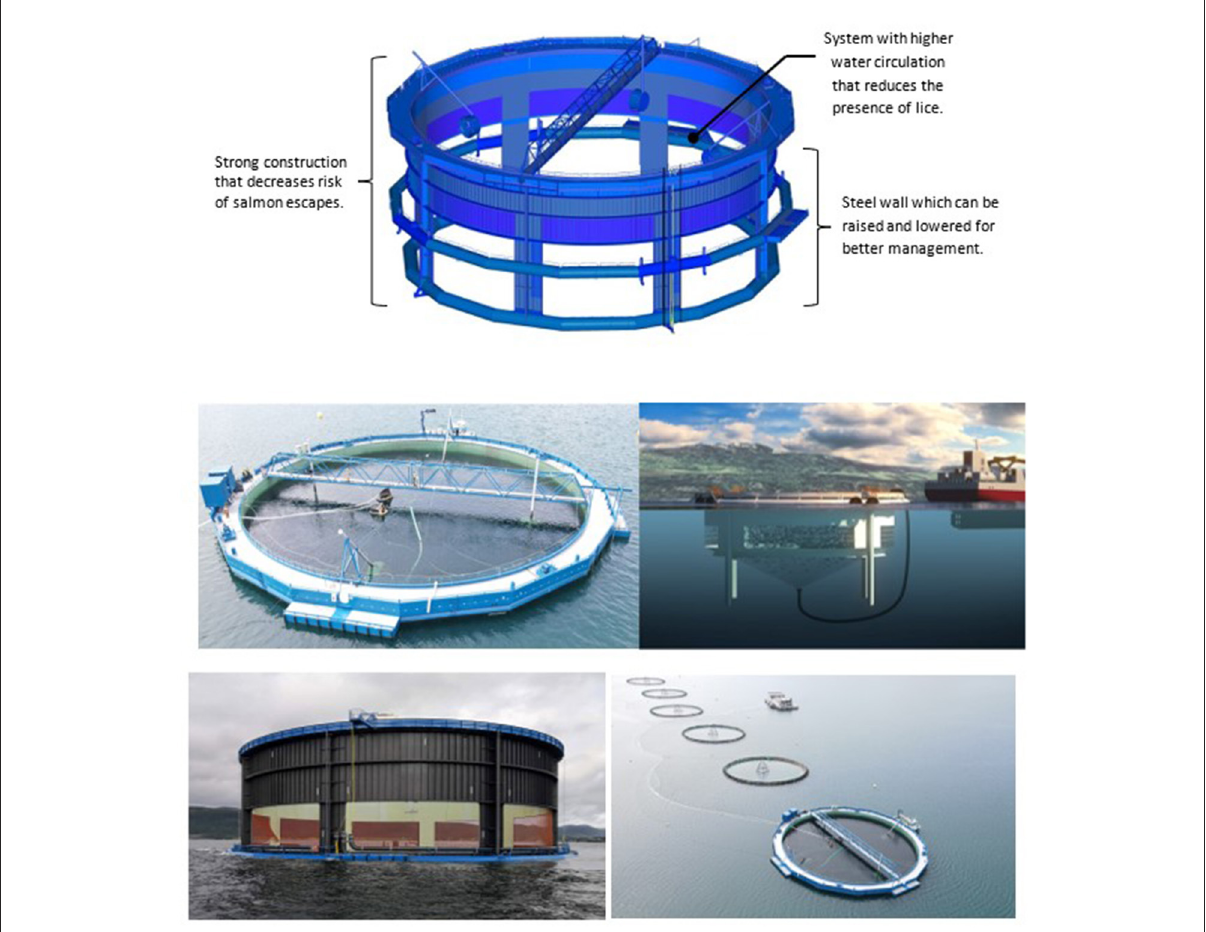
FIGURE3 Aquatraz illustrations courtesy of Midt-Norsk Havbruk AS published in Sandstad et al. (2022). Aquatrazprosjektet—Sluttrapport. Utvikling av semi-lukket st+Ñlmerd fra konsept til kommersielt produkt. Seafarming Systems, SalmoNor, Aqua Kompetanse. Dokumentnummer: AQT-